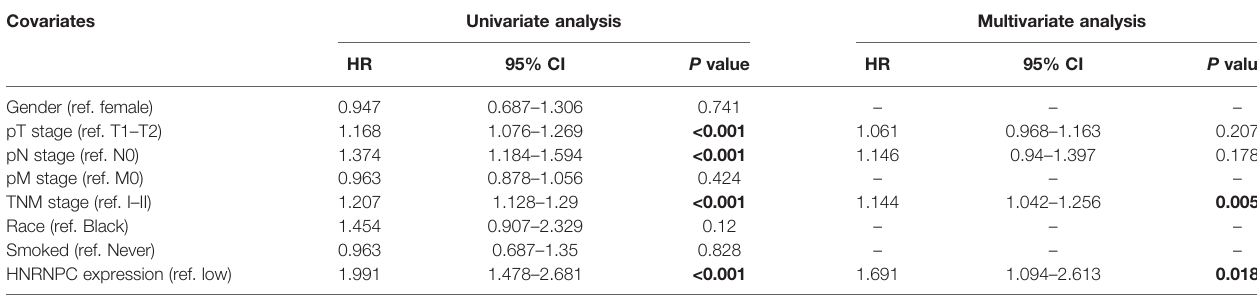
TABLE 2 | Univariate and multivariate Cox logistic regression analysis of OS in The Cancer Genome Atlas (TCGA) cohorts. Covariates Univariate analysis Multivariate analysis HR 95% CI P value HR 95% CI P value Gender (ref.